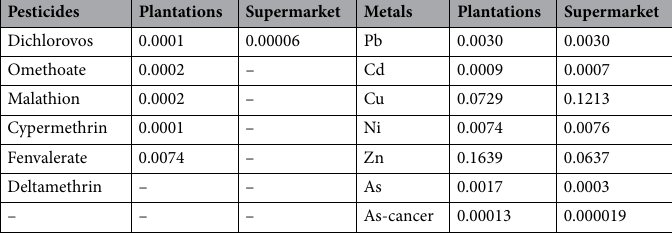
Pesticides Plantations Supermarket